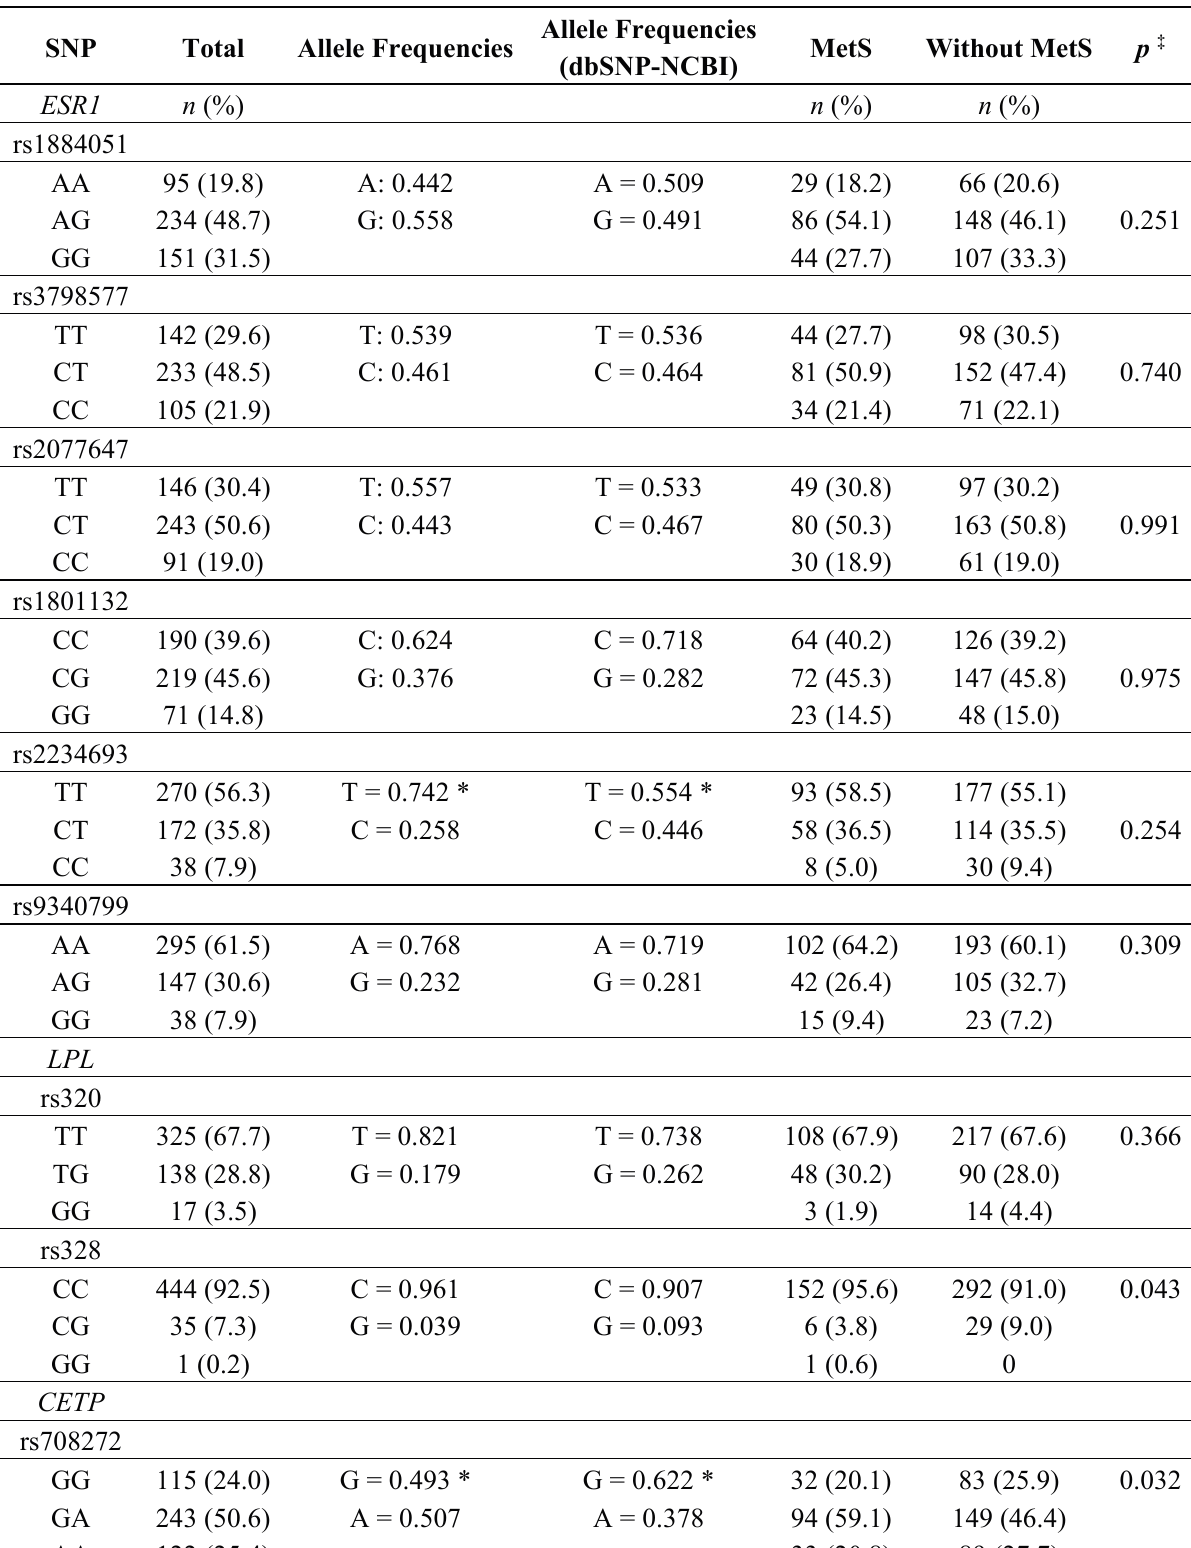
Table 2. Genotype distribution and allele frequencies of the ESR1 , LPL and CETP variants in the women with and without MetS, and allele frequencies reported by the database of SNP